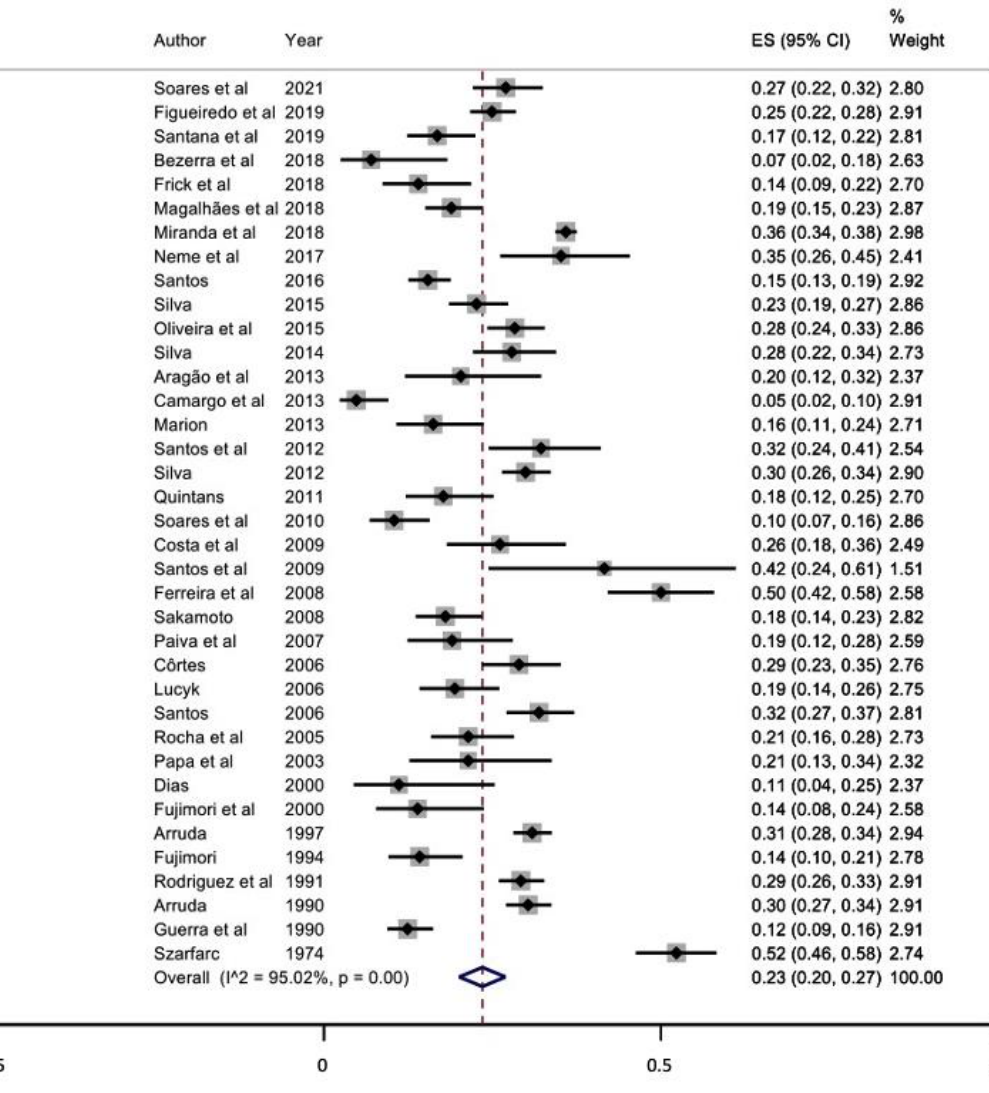
Figure 3. Prevalence of anaemia in Brazilians pregnant women [27 – 63].